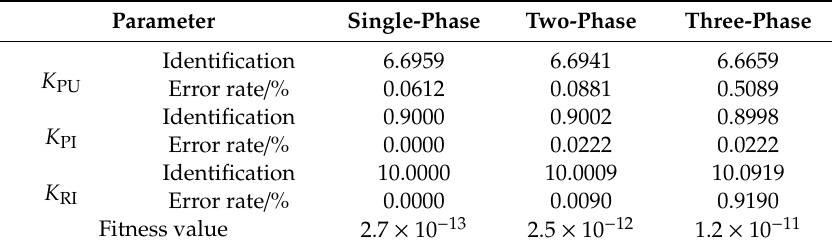
Table 3. Parameter identification results under ADE